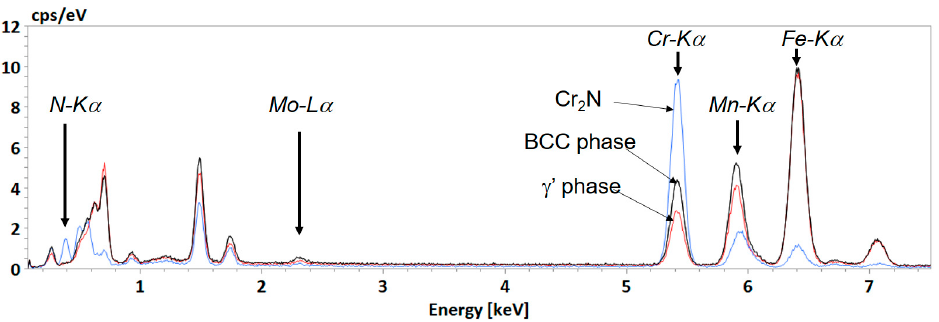
Figure 12. Chemical EDX spectra acquired on some characteristic points on the thin foil. Blue spectrum is recorded in chromium nitride phase, black spectrum in unknown phase, and red one in